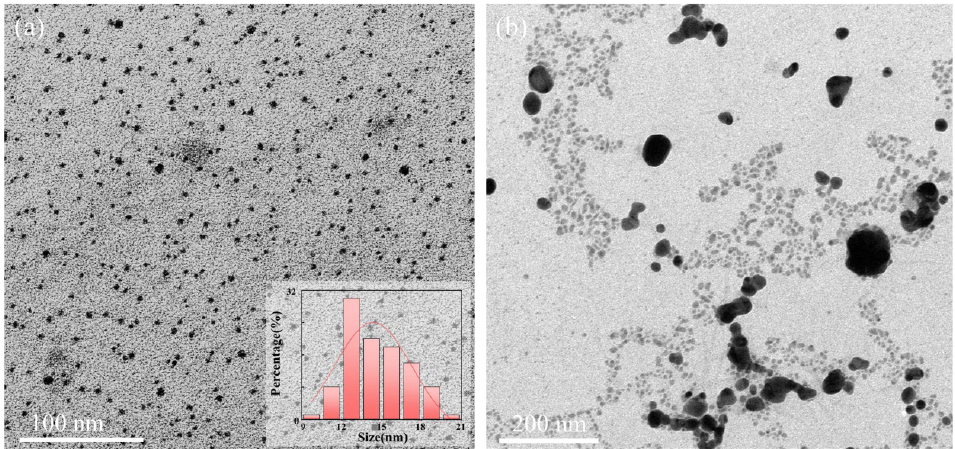
Figure 2. TEM images of ( a ) SA-AgNPs and ( b ) SA-AgNPs with 10 ppm dimethoate. Inset showing the particle size distribution of SA-AgNPs.